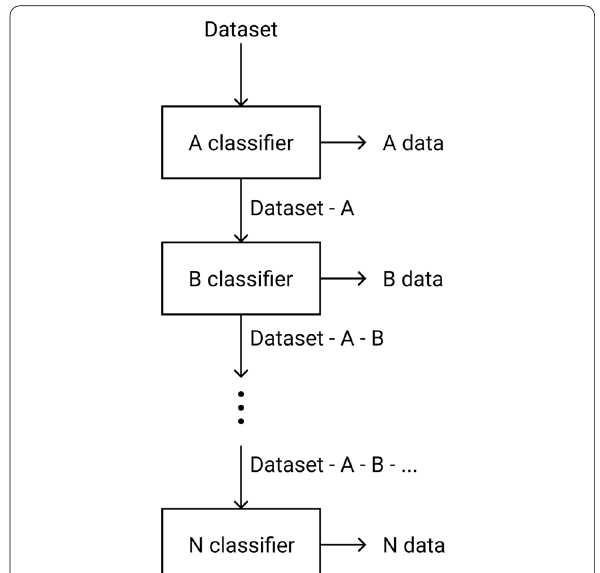
Fig. 6 Proposed multi-class classification architecture